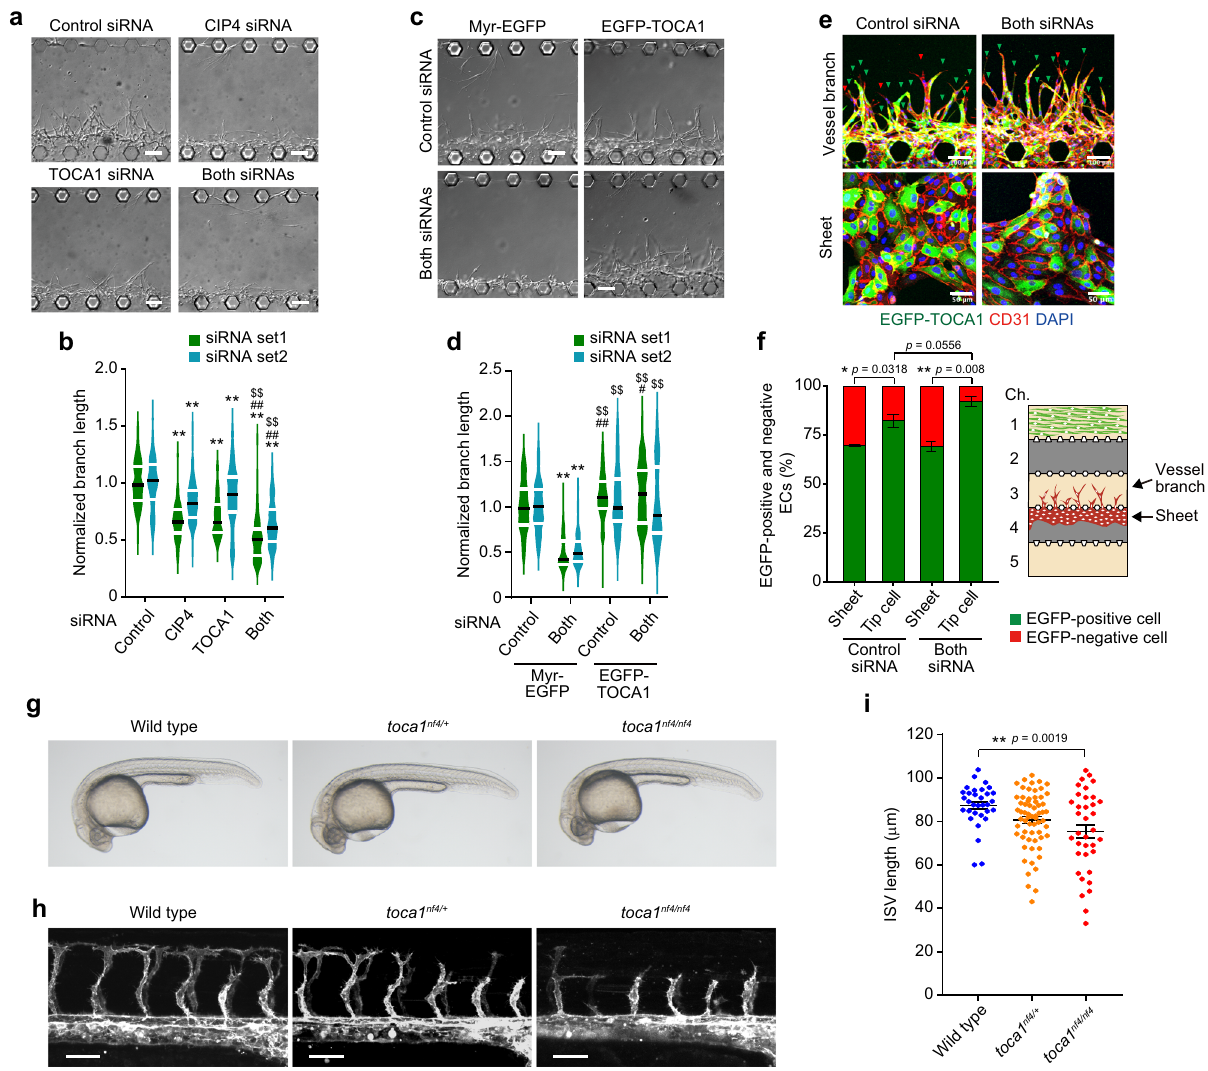
Fig. 6 TOCA family of F-BAR proteins regulate vessel elongation during angiogenesis. a , b Effects of silencing of CIP4 and TOCA1 on branch elongation in on-chip angiogenesis. a DIC images of angiogenic branches constituted by ECs transfected with the control siRNA, CIP4 siRNA, TOCA1 siRNA, or both siRNA (siRNA set1) after 3 days of culture. b Violin plots of branch lengths as in a (green). Lengths of branches constituted by ECs transfected with another set of siRNAs (siRNA set2) are also shown (blue). Black and white lines indicate the median and quartiles, respectively (each group, n = 75 branches examined over 3 independent experiments). ** p < 0.01 versus Control, ## p < 0.01 versus CIP4, $$ p < 0.01 versus TOCA1 by two-way ANOVA followed by Tukey ’ s test. For detailed statistics, see Supplementary Table 4. c , d Rescue of impaired elongation of angiogenic branches constituted by CIP4 and TOCA1 - double knockdown ECs by exogenous expression of EGFP-TOCA1. c DIC images of angiogenic branches constituted by siRNA set1-transfected ECs infected with lentiviruses encoding either Myr-EGFP or EGFP-TOCA1 after 3 days of culture. d Violin plots of branch lengths as in c (green). Lengths of angiogenic branches constituted by siRNA set2-transfected ECs are also shown (blue). Black and white lines indicate the median and quartiles, respectively (each group, n = 120 branches examined over 4 independent experiments). ** p < 0.01 versus Myr-EGFP/Cont.; ## p < 0.01 versus Myr-EGFP/Cont.; $$ p < 0.01 versus Myr-EGFP/Both by the Steel – Dwass test. For detailed statistics, see Supplementary Table 4. e , f Positions of EGFP-TOCA1-transduced ECs in on- chip angiogenic branches. e Confocal z -projection images of angiogenic branches constituted by ECs transfected with control siRNA (Control siRNA) or siRNA set1 (Both siRNAs) and infected with lentivirus encoding EGFP-TOCA1 in channel 3 of the micro fl uidic device (upper panel) and those of sheet- forming ECs in channel 4 (lower panel). Green, EGFP-TOCA1; red, CD31; blue, DAPI. Green and red arrowheads indicate EGFP-positive and negative tip ECs, respectively. f Percentages of EGFP-positive (green) and negative (red) cells localized at a tip position in angiogenic branches (Tip cell) and percentages of EGFP-positive (green) and negative (red) cells in ECs forming the sheet (Sheet), as in e . Data are means ± s.e.m. (each 5 independent experimental samples). * p < 0.05, ** p < 0.01 by two-sided Mann – Whitney U test. g Representative bright- fi eld images of wild-type (left), toca1 nf4/ + (middle), and toca1 nf4/nf4 (right) zebra fi sh embryos at 28 hpf. h Confocal z -projection images of trunk vasculature in 28 hpf Tg( fl i1a:lifeact-mCherry) embryos with the indicated genotypes. Lateral views with anterior to the left. i Quanti fi cation of ISV length, as in h . Each dot represents an individual embryo. Data are means ± s.e.m. (wild type, n = 32; toca1 nf4/ + , n = 63; toca1 nf4/nf4 , n = 36). ** p < 0.01 by one-way ANOVA followed by Tukey ’ s test. Source data are provided as a Source data fi le. Scale bars: 100 µ m ( a , c , e ), 50 µ m ( h